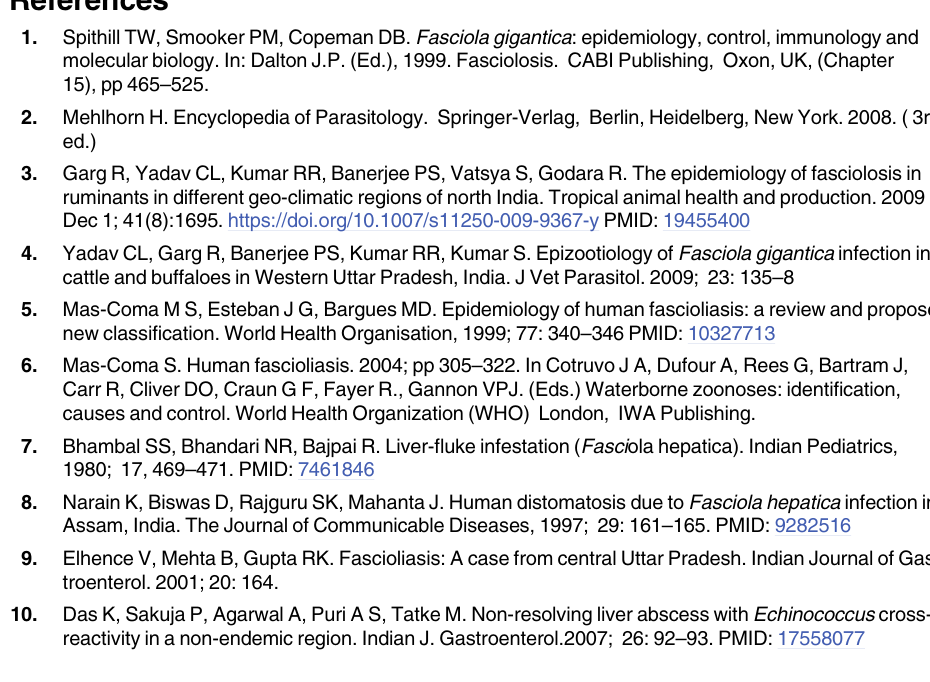
S3 Fig. Western blot of MAO-A in F . gigantica adult worms (lane 1 and 2). Note: Lane 2 is not the part of main figure.